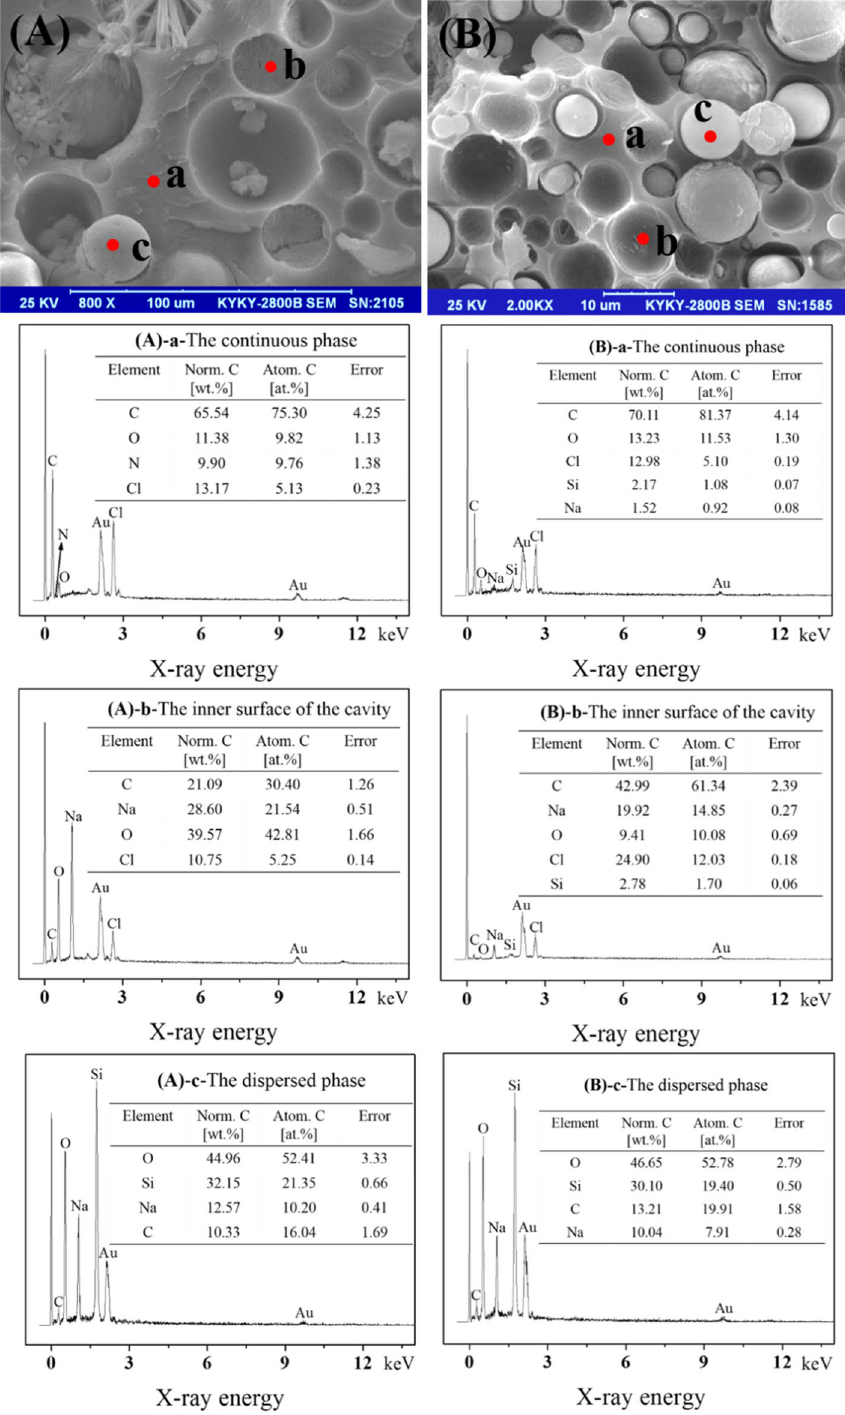
Figure 5. SEM images and EDS spectra of the fracture surface of ( A ) non-modified SS/PU and ( B ) modified SS/PU composites ( a : the continuous phase, b : the inner surface of the cavity and c : the dispersed